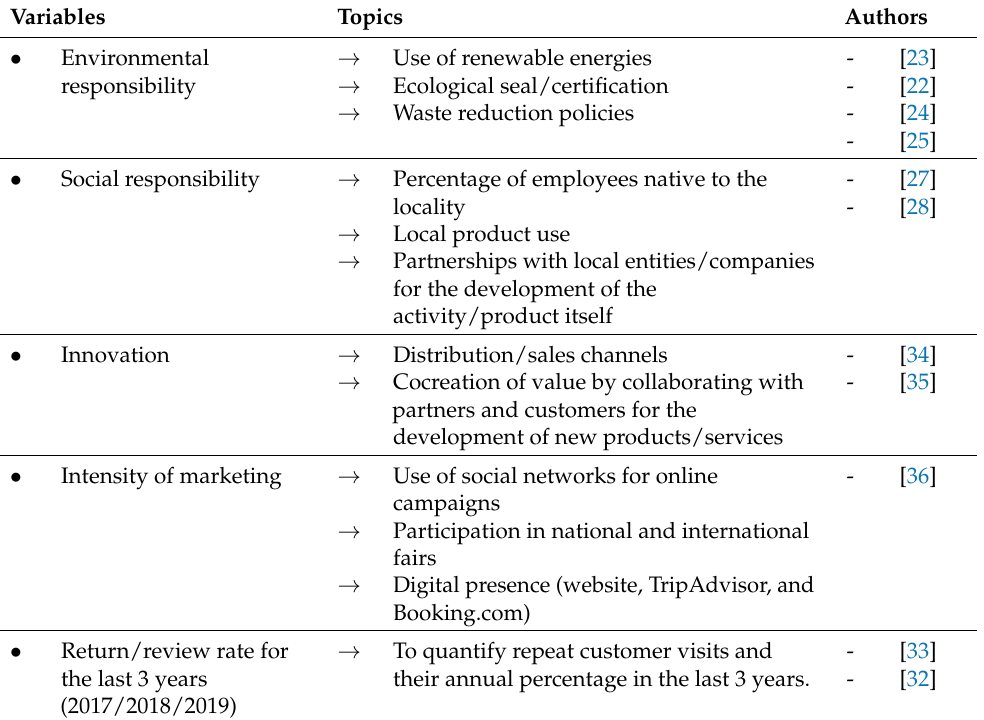
Table 2. Study variables and inherent topics.